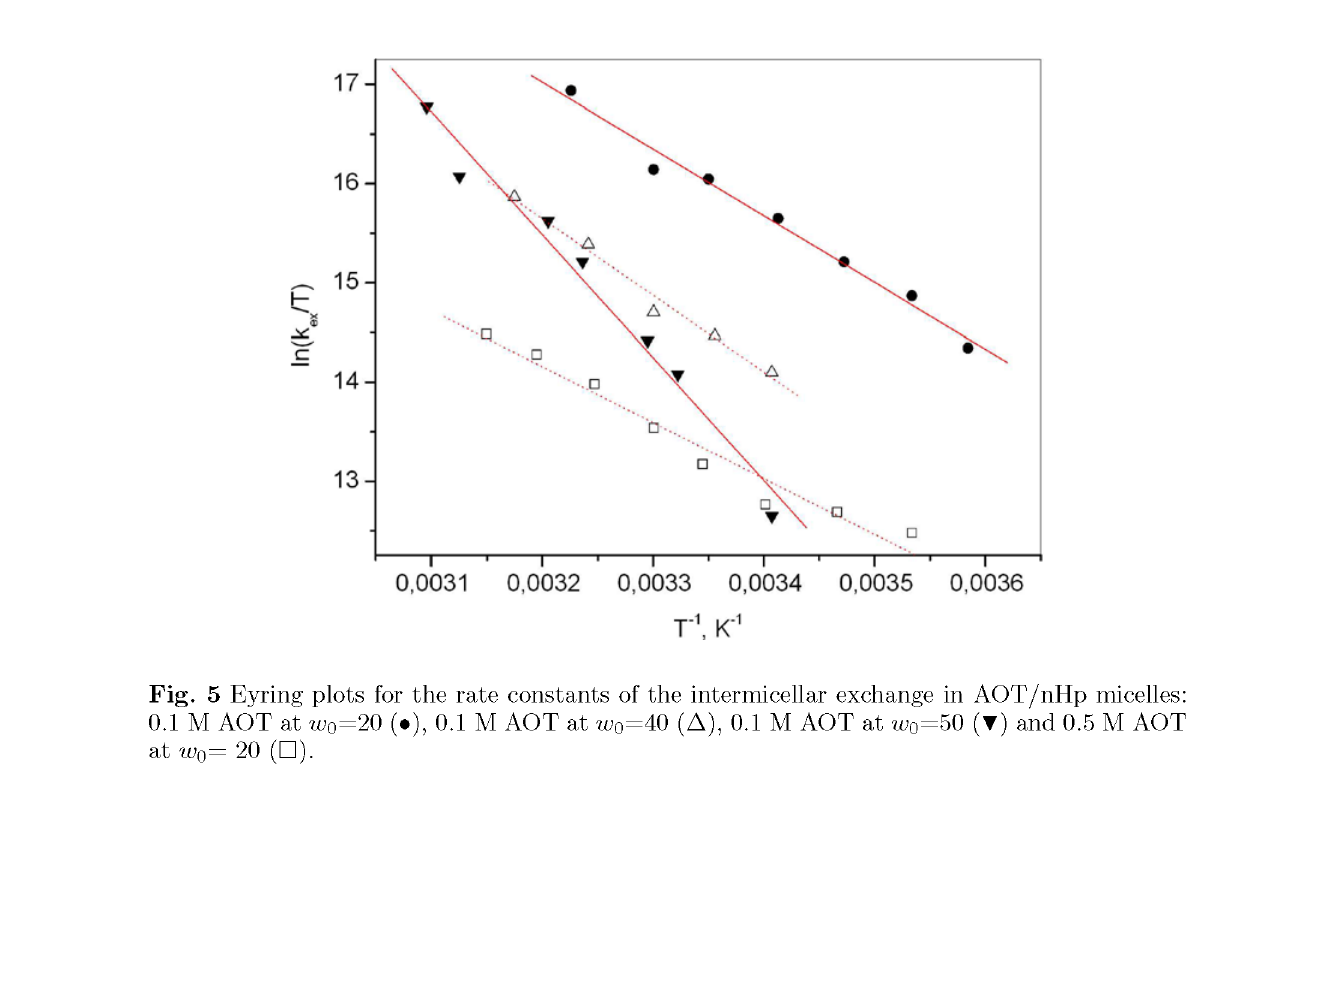
Fig. 5 Eyring plots for the rate constants of the intermicellar exchange in AOT/nHp micelles: